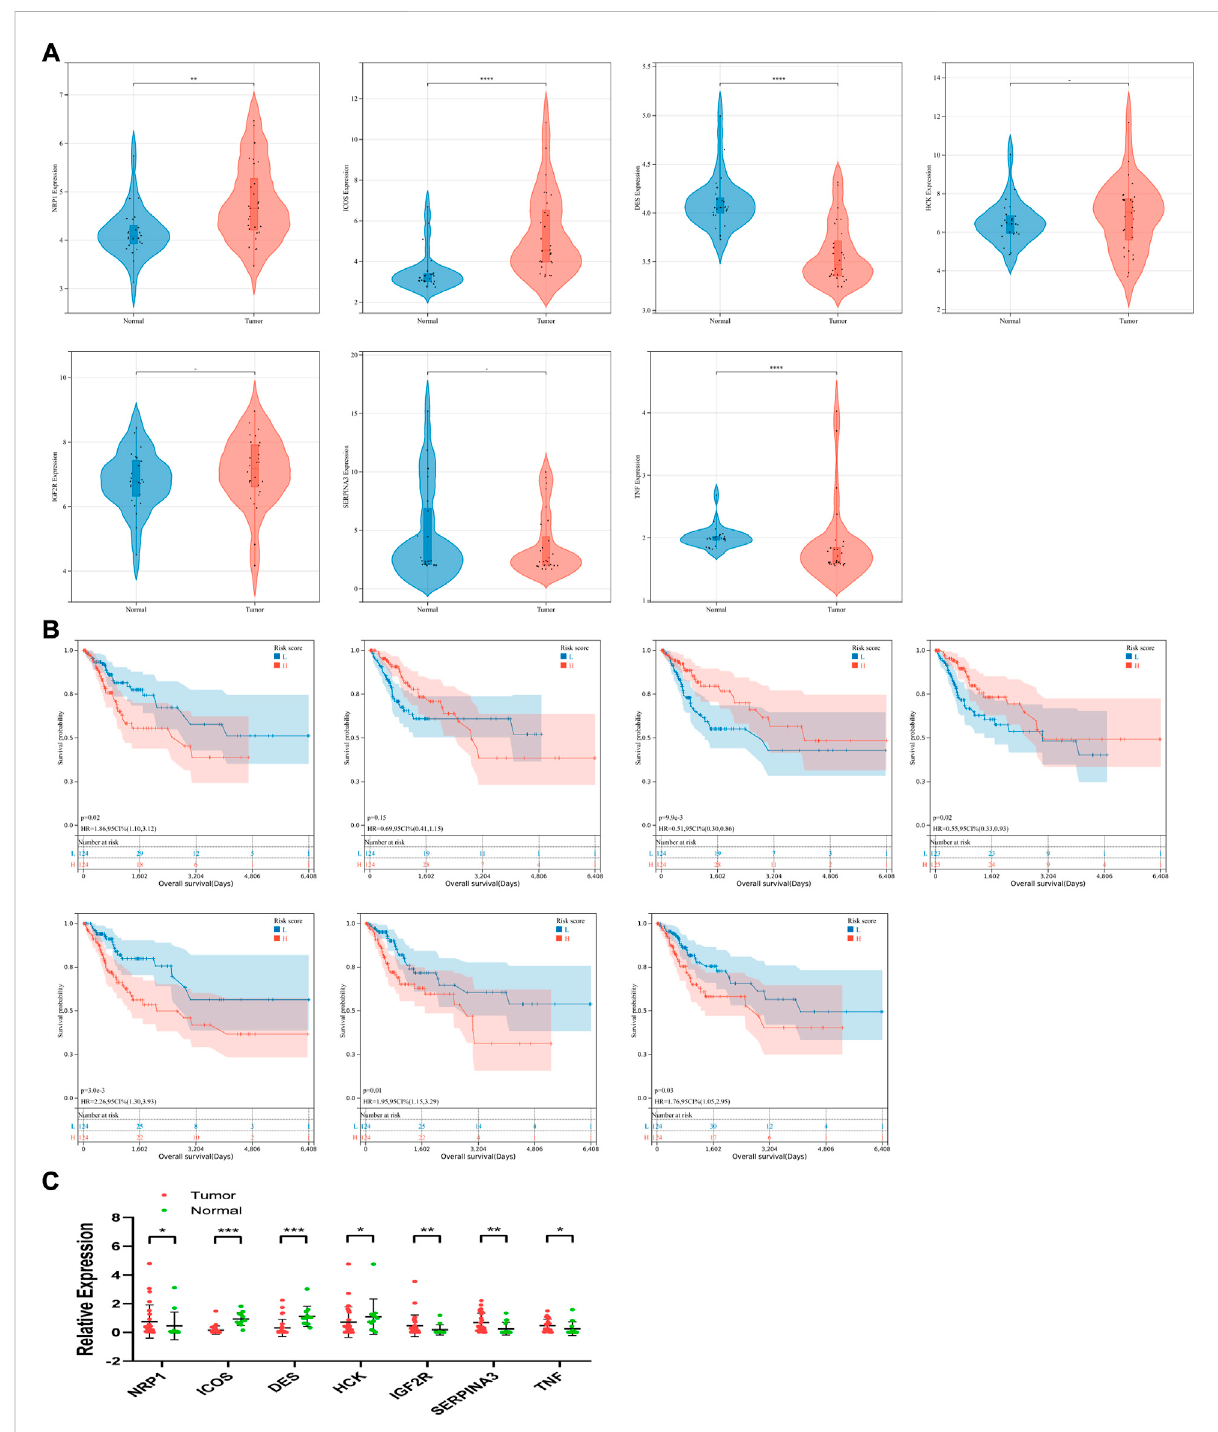
FIGURE 7 Expression levels, survival analysis and clinical sample validation ofseven candidate genes. (A) Based on thesignature,expressionlevels of each gene werecomparedin low- and high-risk group inGSE63514. (B) Survival analysis of eachgene (from leftto right, top to bottom: NRP1, ICOS,DES, HCK, IGF2R, SERPINA3 and TNF) was conducted in the whole TCGA-CSCC set. (C) Expression levels was analyzed using